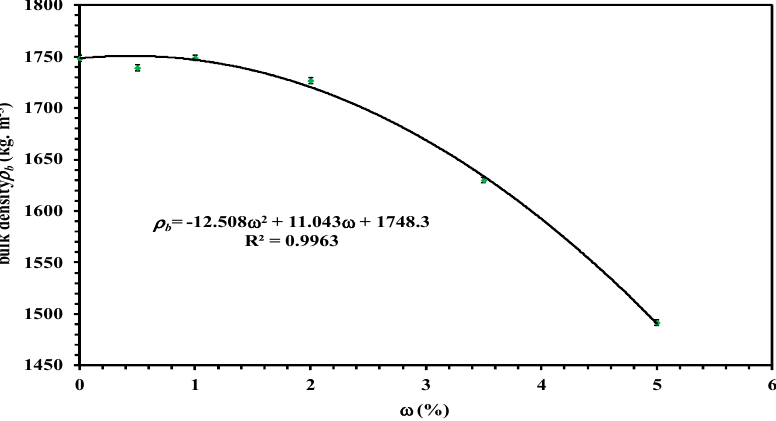
Figure 7. Effect of AF mass ratio on bulk density at day 28. Measurements uncertainty is below 0.2%.